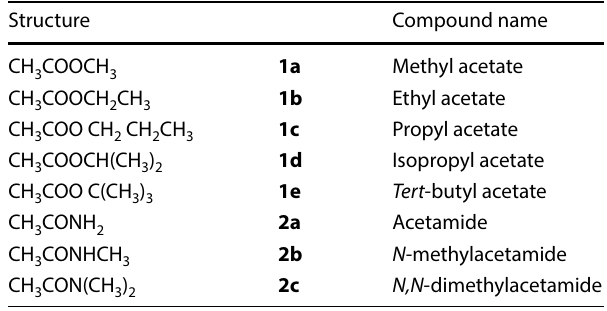
Table 2 Alkyl acetates 1 and acetamides 2 used for the iodoform test